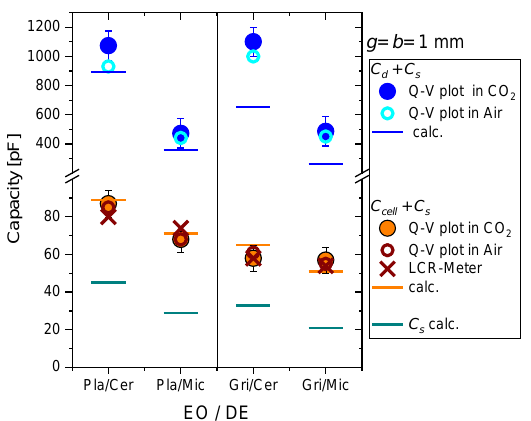
Figure 5. Capacitances of the four different combinations of electrode and dielectric plate (DE) for β